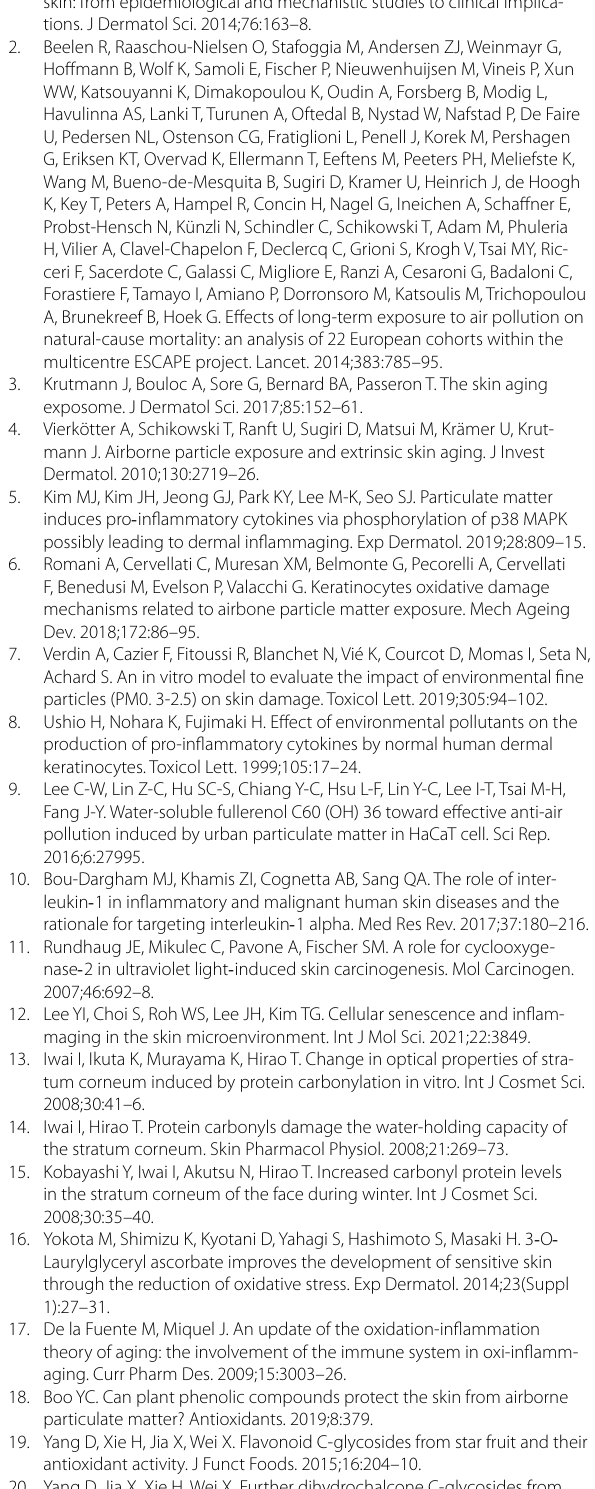
SFE. Table S2. Activity against NaClO‑induced protein carbonylation in SC. Table S3. Activity against GEEG‑induced protein carbonylation in